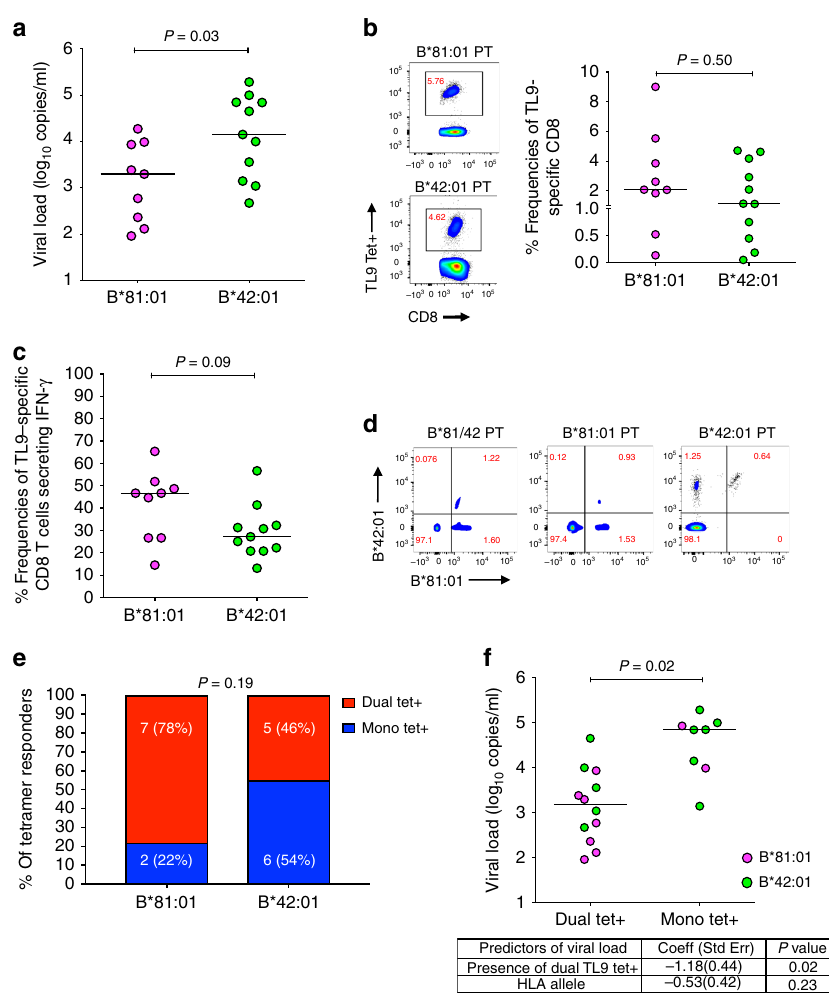
Fig. 1 A dual TL9 tetramer + response is associated with lower plasma viral load. A comparative analysis indicated lower plasma viral loads (log 10 ) among participants expressing B*81:01 compared to participants expressing B*42:01 ( p = 0.03, Mann – Whitney U-test test) ( a ). Representative fl ow plots display TL9 tetramer responses observed in one B*81:01 expressing individual (top) and one B*42:01 expressing individual (bottom). A comparative analysis of TL9 tetramer + frequencies observed no difference between participants expressing B*81:01 compared to those expressing B*42:01 ( p = 0.5; Mann – Whitney U-test) ( b ). A comparative analysis of IFN- γ secretion following stimulation with TL9 peptide indicated a trend toward higher activity among individuals expressing B*81:01 versus B*42:01 ( p = 0.09, Mann – Whitney U-test) ( c ). Representative fl ow plots display the dual TL9 tetramer- reactive T cell population in B*81/42:01 expressing participant, one B*81:01 expressing participant and one B*42:01 expressing participant ( d ). A higher proportion of B*81:01 expressing participants displayed dual-tetramer reactivity ( p = 0.19, Chi-square test) ( e ). Multivariable linear regression analyses that included HLA allele and presence of dual-tetramer reactive T cells as independent variables indicated that dual-reactivity ( p = 0.02) but not HLA ( p = 0.23) was a signi fi cant determinant of plasma viral load ( f